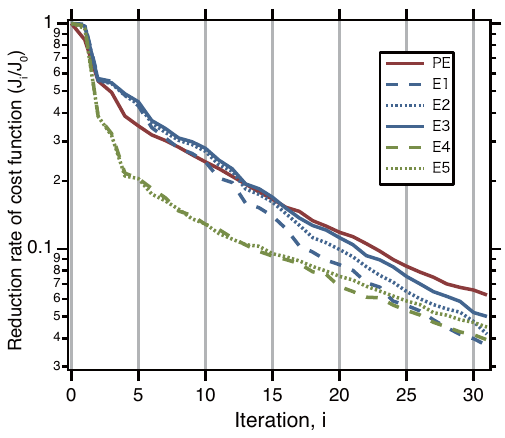
Fig. 7. Reduction rate of the cost function on a log